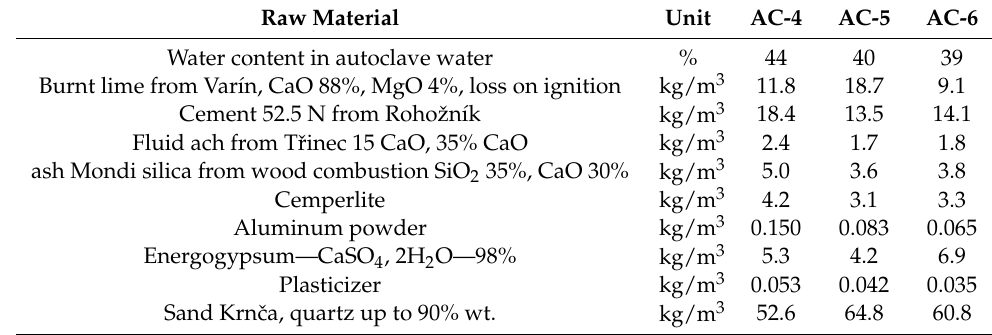
Figure 1. A 200× magnified microstructure of the autoclaved aerated concrete (AAC) samples: ( a ) Figure 1. A 200 × magnified microstructure of the autoclaved aerated concrete (AAC) samples: AC-4; ( b ) AC-5; ( c ) AC-6. ( a ) AC-4; ( b ) AC-5; ( c ) AC-6. Table 1. The samples’ composition. Table 1. The samples’